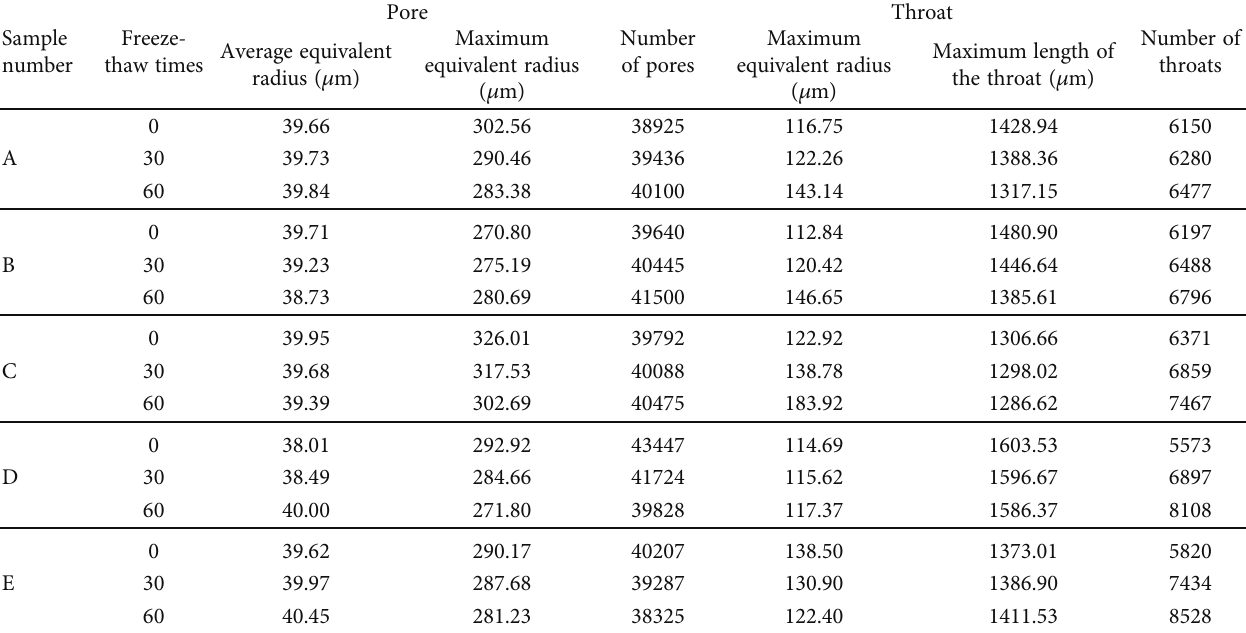
Table 4: Pore and throat